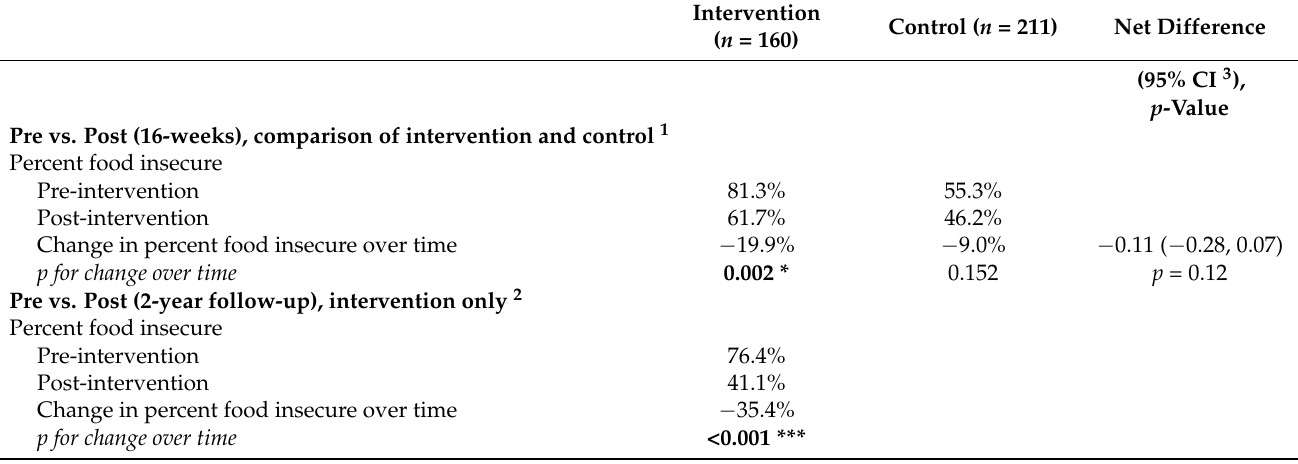
Table 2. Estimated changes in percent food insecure among parent–child dyads ( n = 371), by inter- vention